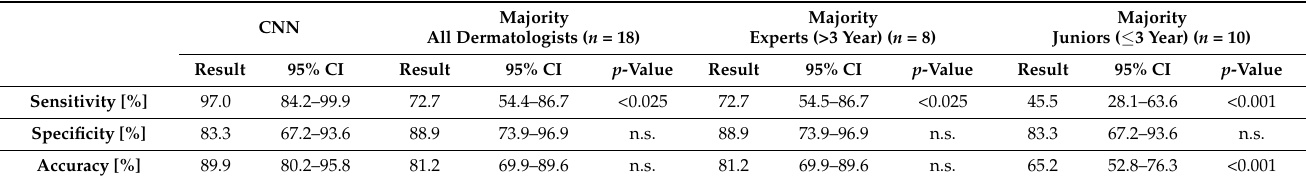
Table 1. Statistical analysis from the man vs. machine comparison. For experience group analysis, the majority decided on the final diagnoses made per image, 95% confidence intervals are exact binomial Clopper–Pearson intervals, group size n is given in the header rows. Indicated p -values are McNemar’s significance levels for the difference to CNN performance (for non-significant differences with p > 0.1 ‘n.s.’ is